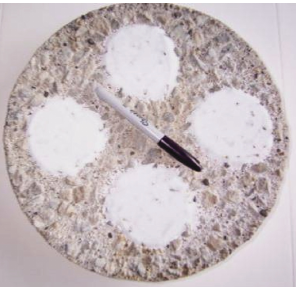
Fig. 2. Volumetric sand patch tests performed on an exposed aggregate concrete sample